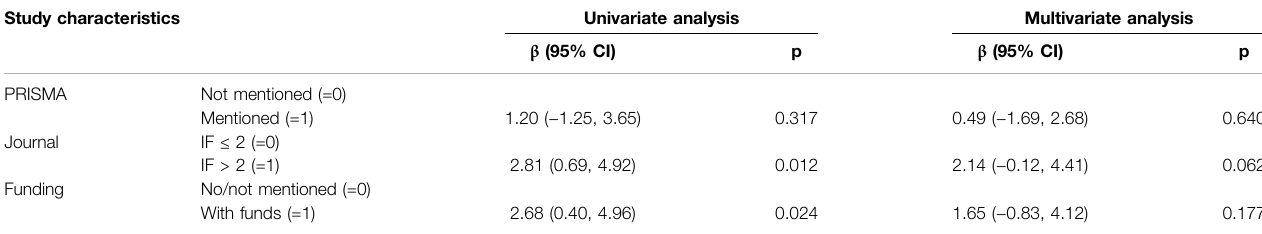
TABLE 2 | Univariate and multivariate analyses of the methodological quality score. Study characteristics